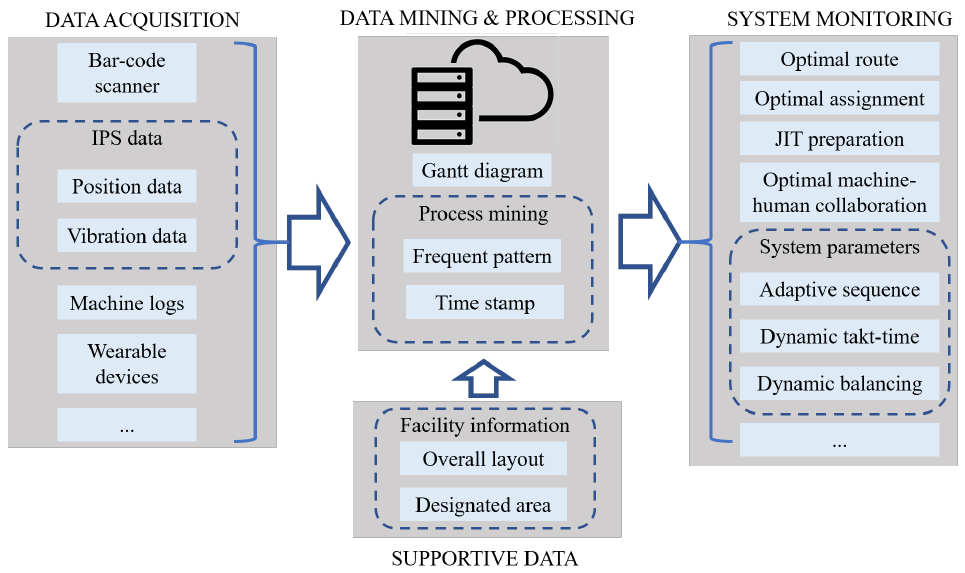
Figure 1. The proposed framework of Lean 4.0 data-driven